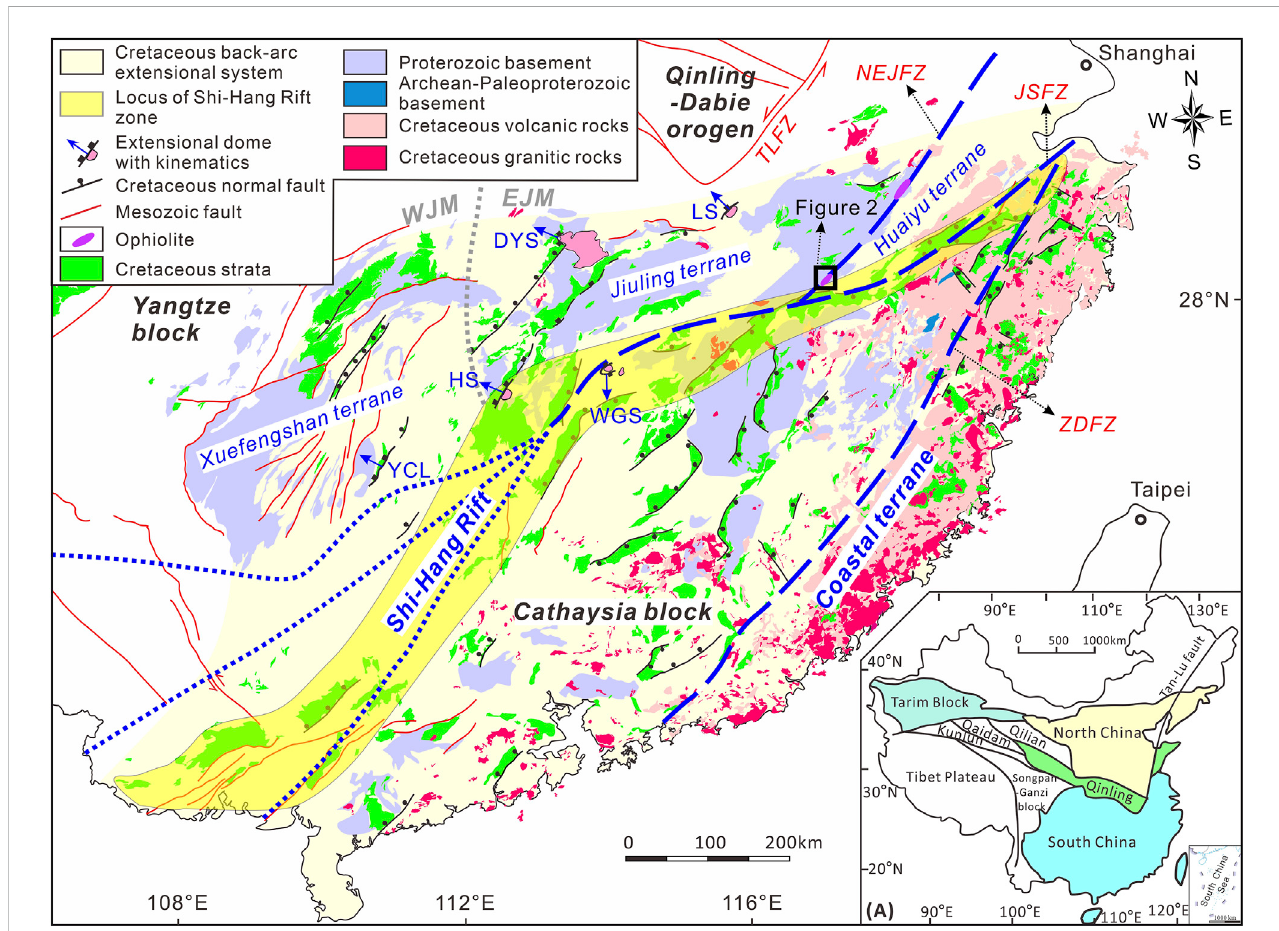
FIGURE 1 Tectonic map and Cretaceous extension-related records of South China (modi fi ed from Gilder et al., 1996; Wang et al., 2014; Chu et al., 2019; Li et al., 2022; Wang et al., 2022). Abbreviations for extensional domes and fault zones: WJM, western Jiangnan Massif; EJM, eastern Jiangnan Massif; TLFZ, Tancheng – Lujiang fault zone; NEJFZ, northeastern Jiangxi Province fault zone; JSFZ, Jiangshan – Shaoxing fault zone; ZDFZ, Zhenhe – Dabu fault zone; DYS, Dayunshan dome; HS, Hengshan dome; LS, Lushan dome; WGS, Wugongshan dome; YCL, Yuechengling